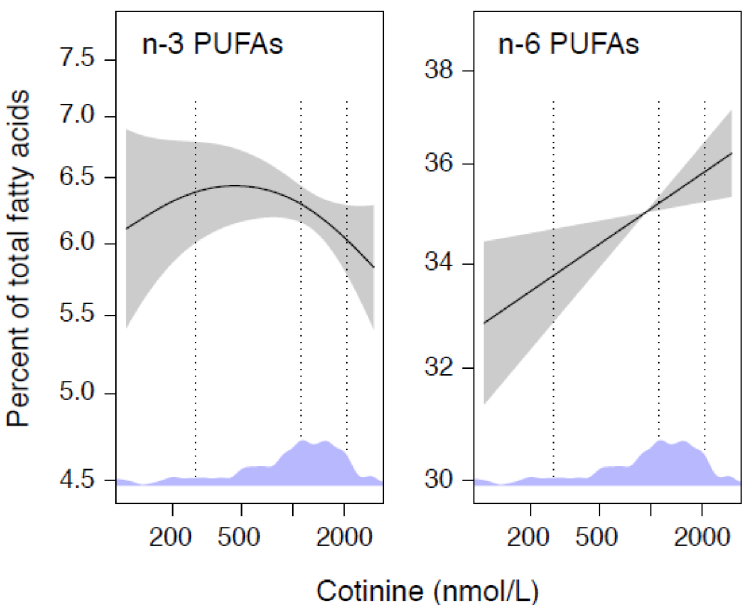
Fig 2. The relationship between cotinine and serum n-3 and n-6 PUFAs. The dose-response relationships between concentrations of plasma cotinine levels (nmol/L) and serum PUFAs (% of total fatty acids) in smokers (n = 459). Associations were modeled by GAM and adjusted for gender and age. Shaded areas indicate 95% confidence intervals. The y-axis spans 2 standard derivations of each outcome. Density plot for the distribution of cotinine are included in diagrams with 10 th , 50 th and 90 th percentile marked by dotted, vertical